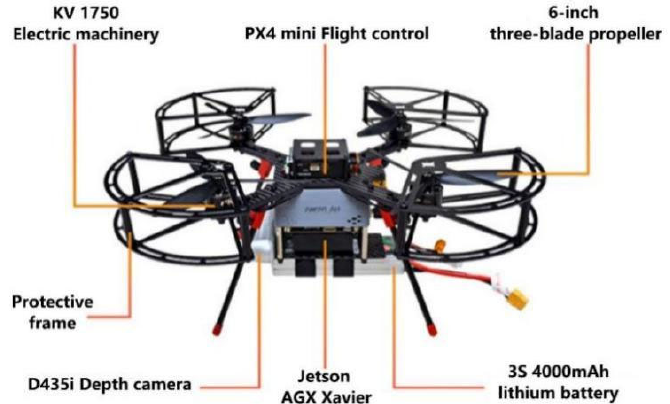
Figure 1. Prototype of the proposed autonomous object-tracking system.